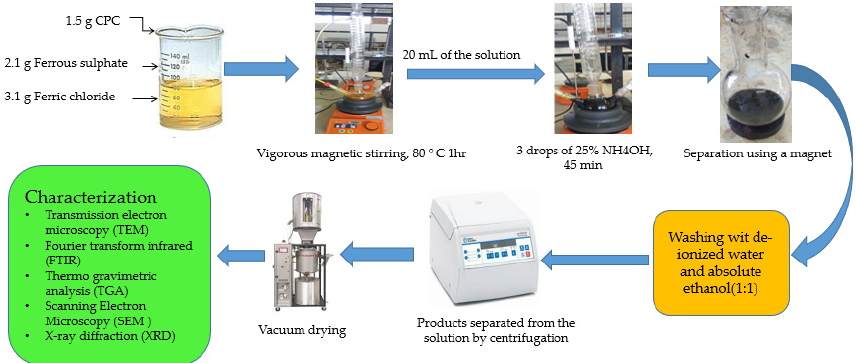
Figure 2. The schematic diagram for the synthesis of CPC-MNPs.